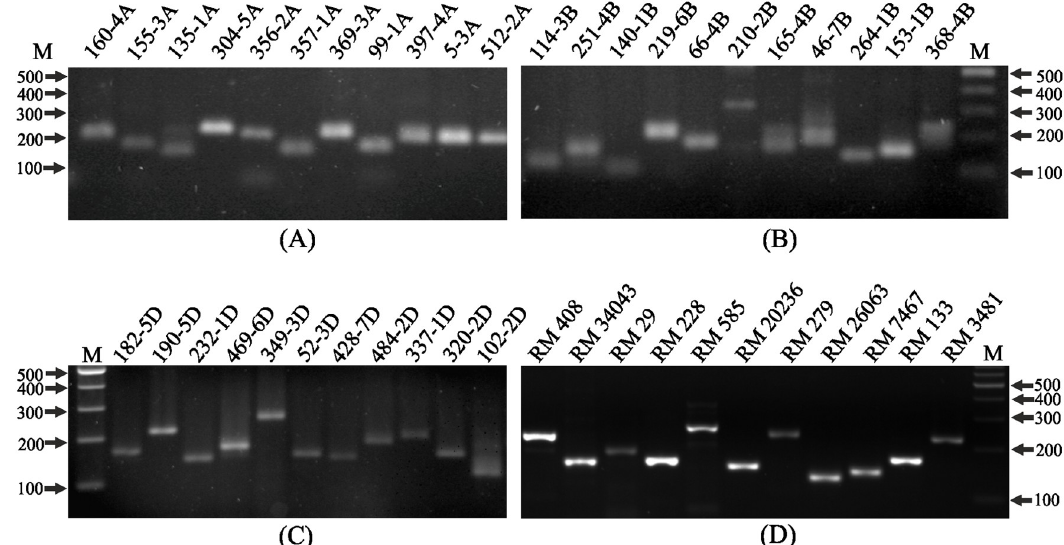
Fig 1. Analysis of PCR amplified STMS markers on 2% agarose gel. A) wheat A-genome STMS markers, B) wheat B-genome STMS markers, C) wheat D-genome STMS markers, and D) rice STMS markers. Designations of the STMS markers are indicated on the top of the lanes. Lane ‘M’ indicates 100 bp